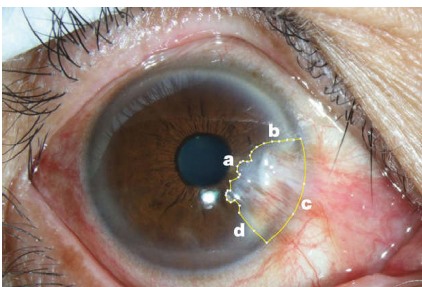
Figure 1: ImageJ software used to calculate the size of the pterygium (a) Edge of the pterygium head; (b) Edge of the upper boundary of the pterygium; (c) Edge of the nasal border of the pterygium, coinciding with the border of the limbus; (d) Edge of the lower boundary of the